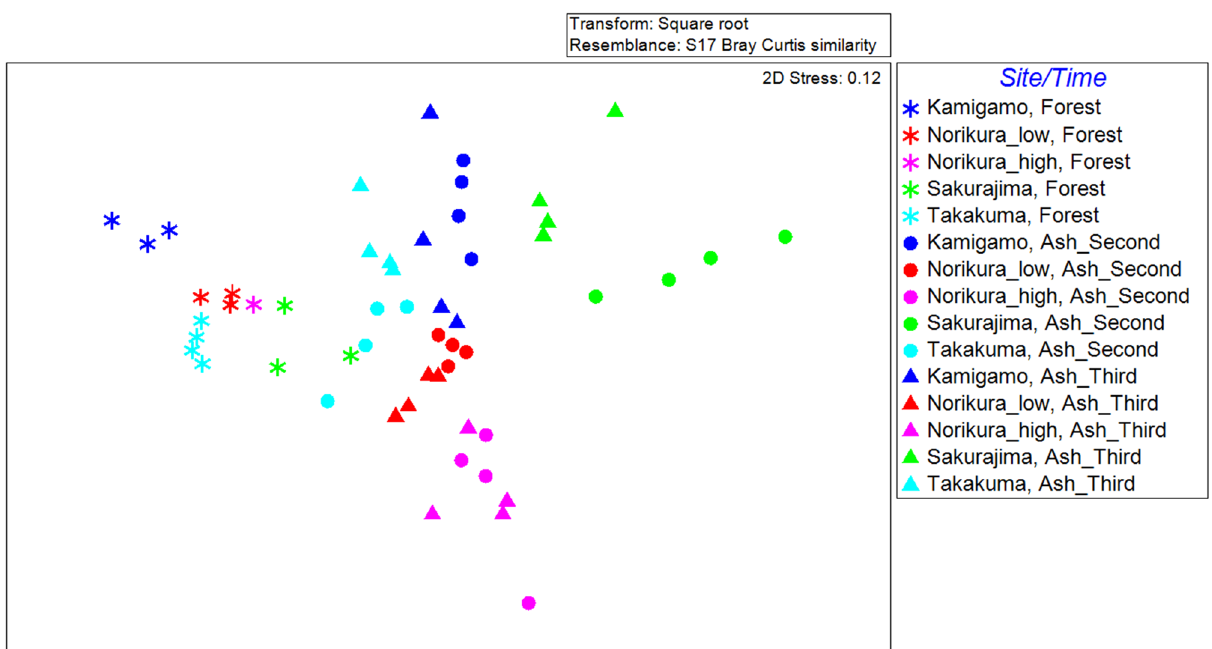
Figure 3. nMDS plot drawn based on Bray–Curtis dissimilarity of Subsystem level4 functional gene composition between samples.